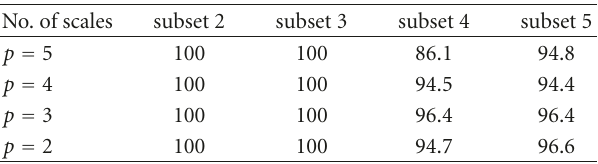
Table 3: Rank one recognition rates (in %) obtained with PBGFC technique on the EYB database for di ff erent numbers of filter scales employed during construction of the OGPCIs.